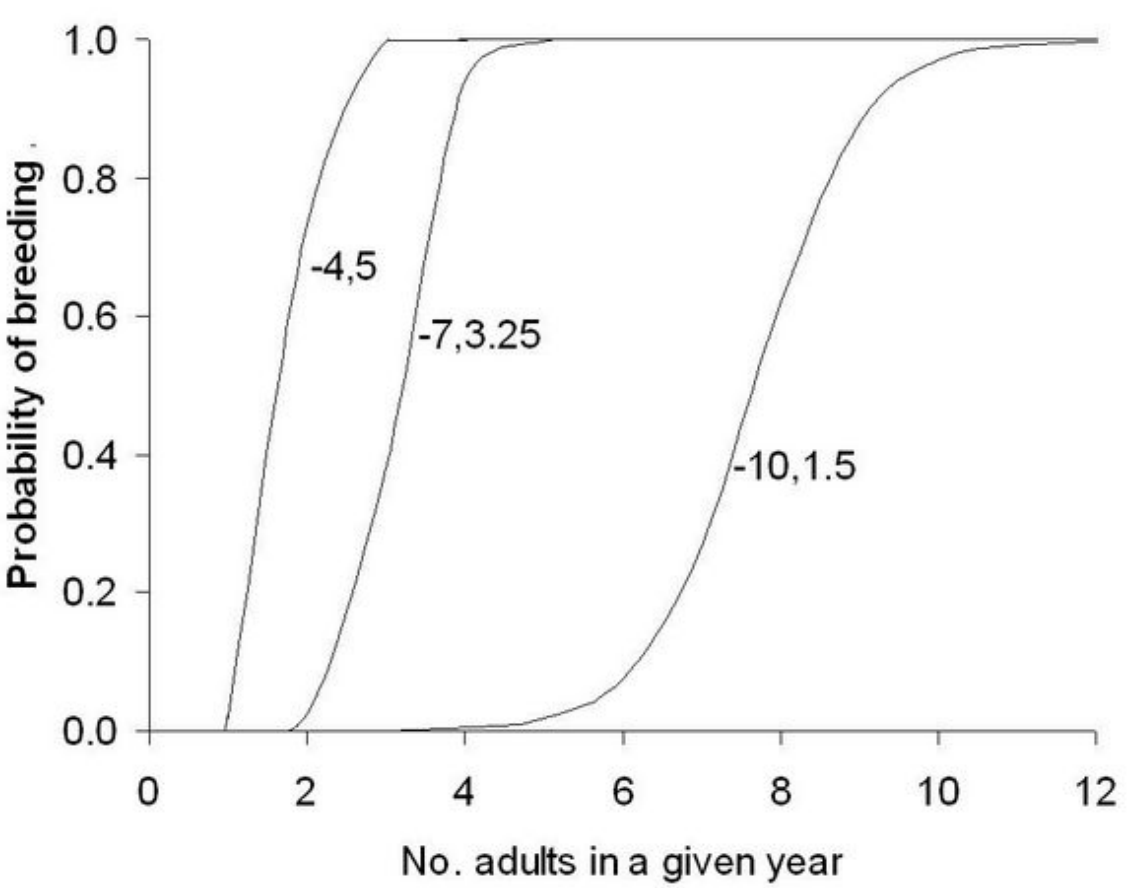
) and slope (ß ) of the relationship 0 a , ß ). Population sizes 0 a